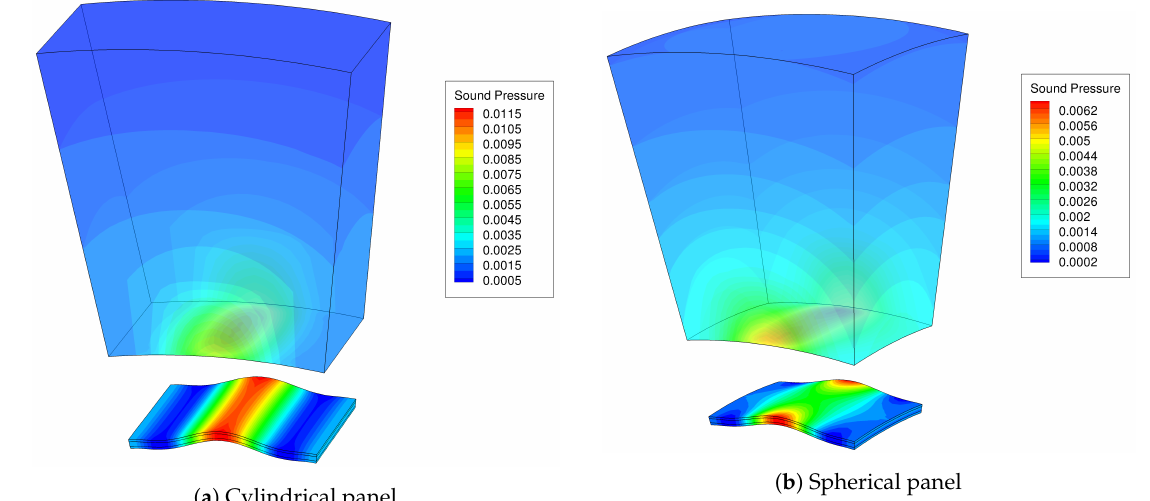
Figure 10. Clamped-free rectangular cylindrical and spherical shells with R α = R β = 1 m. Three-dimensional representation of the Sound Pressure (Pa) transmitted by the shell panels at f = 300 Hz from the top shell surface to a radial distance of 0.5